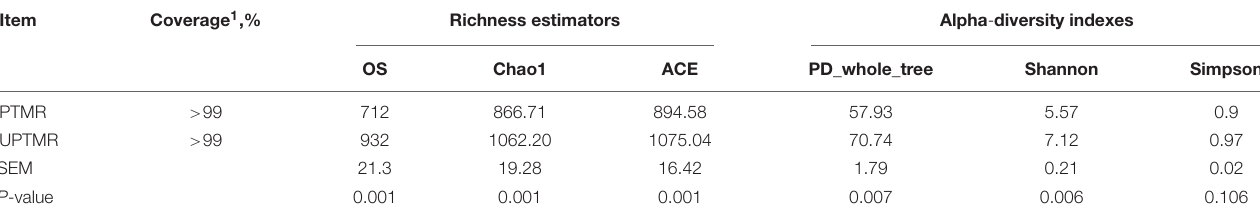
TABLE 3 | Alpha-diversity indices of the ruminal microbiota of lambs fed different types of total mixed ration (TMR).